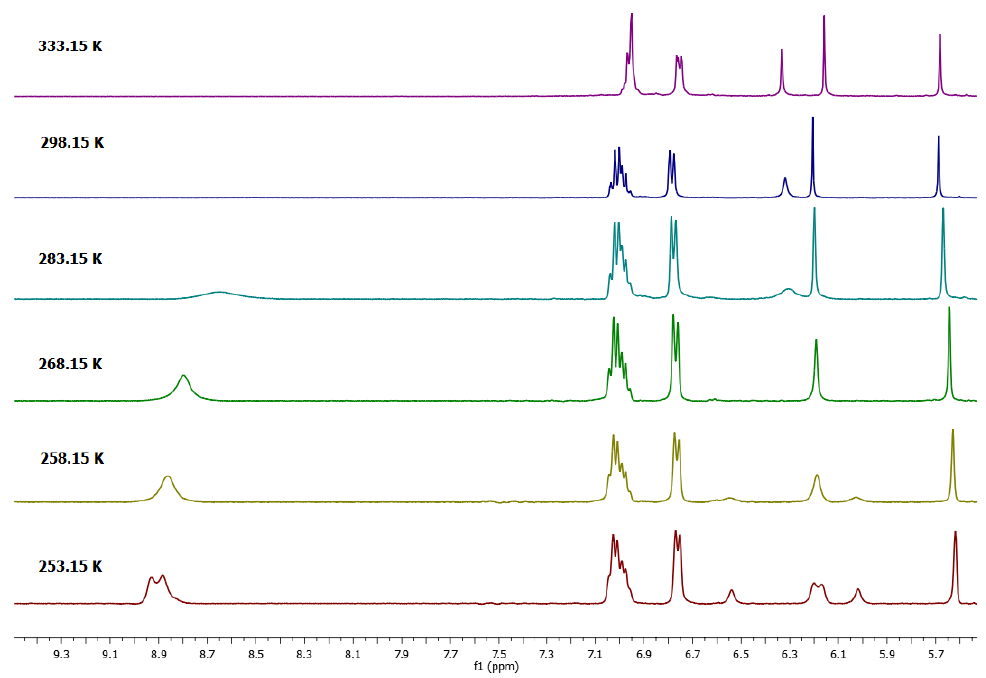
Figure 2. Dynamic study of tetra(phenyl)-resorcin[4]arene ( 1a ) in MeCN-DMSO-d 6 mixture.